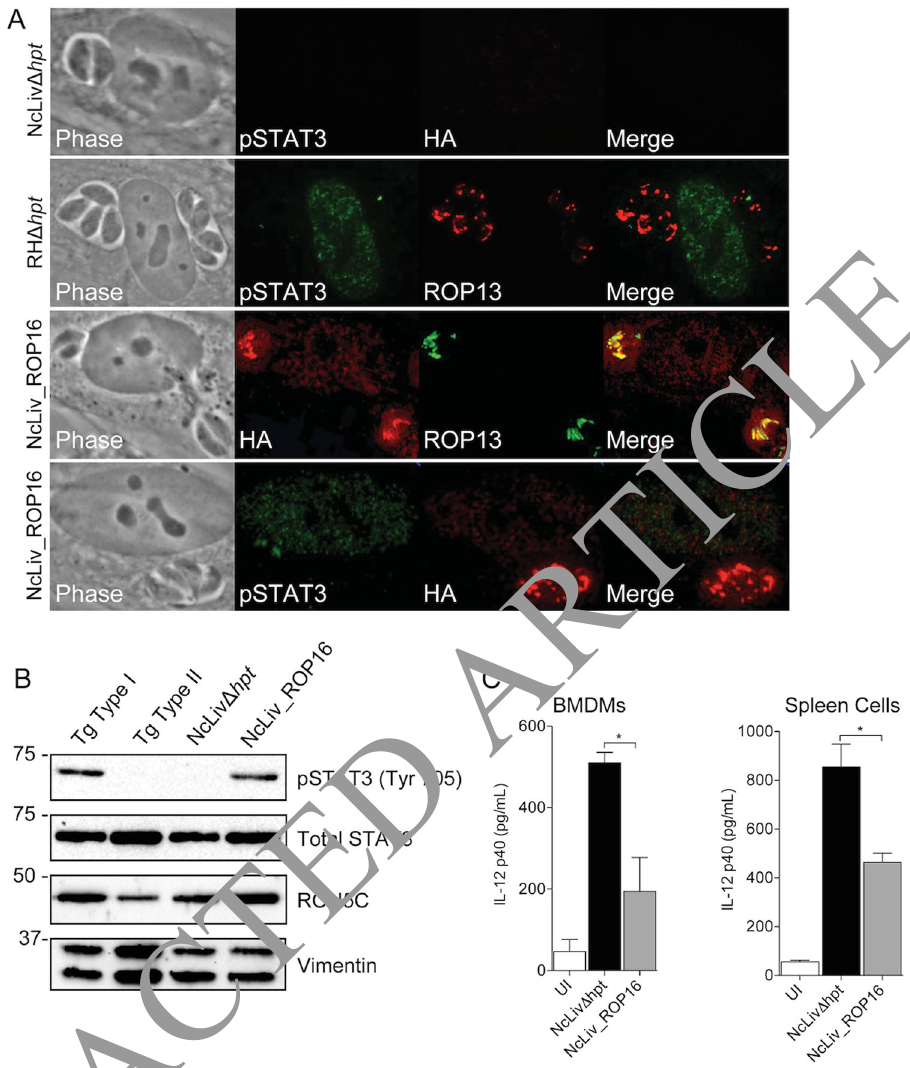
Figure 8. ROP16 expression induces STAT3 phosphorylation and down-modulation of IL-12p40 production. ( A ) Immunofluorescence analysis of ROP16-dependent activation of STAT3. HFFs were infected with type I T. gondii , NcLiv Δ hpt or NcLiv_ROP16 (MOI 10) for 18 h, fixed and incubated with antibodies against parasite HA tag, Rop13 or the phosphorylated forms of STAT3 (Tyr 705). Microscope magnification: 63x. ( B ) Western blot analysis of ROP16-dependent phosphorylation of STAT3. Serum-starved HFFs were infected with a type I and type II strains of T. gondii , NcLiv Δ hpt or NcLiv_ROP16 and 18 h after infection, cells were lysed and analysed by immunoblotting. Virmetin (host cell-specific) and RON5C (parasite-specific) levels are shown as loading controls, ( C ) NcLiv_ROP16 inhibits IL- 12p40 in infected macrophages and spleen cells. Values are representative of two independent experiments indicating mean ± SEM of cytokine levels in relation the standard curve ( * P < 0.05; ANOVA and Bonferroni multiple comparison post-test). Full-length blots are available in Supplementary dataset file. constant drug pressure for selection, which may be used as a parental strain when tested in parallel with N. can- inum expressing foreign proteins. We also determined specific N. caninum promoters (ROP13: NCLIV_055850; GRA7: NCLIV_021640) that correctly and abundantly express genes associated with both constitutive and cyclical cell cycle expression pro- files, which provides a more stable and efficient protocol during the desired genetic manipulation in NcLiv Δ hpt strains. The expression of gene targets through both promoters induced a higher number of positive populations, simplifying the process of obtaining positive clones from the transfected populations. Additionally, the genera- tion of N. caninum tachyzoites expressing mCherry and GFP - driven by those promoters - are relevant tools to quantify and detect parasite burden. Those strains can be used in experiments that rely on microscopy and flow cytometry, during in vitro and in vivo assays, to detect and phenotype parasite-harboring cells or tissue cysts. To date, the detection and quantification of N. caninum required parasite-specific antibodies, fluorescent probes 27 , genomic DNA quantification 27 or, recently, by using transgenic parasites expressing Lac-Z 26 . All of these methods